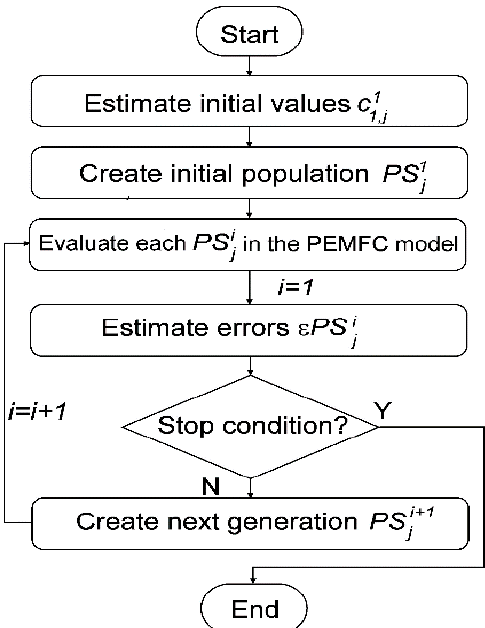
Figure 5. Global identification process algorithm.